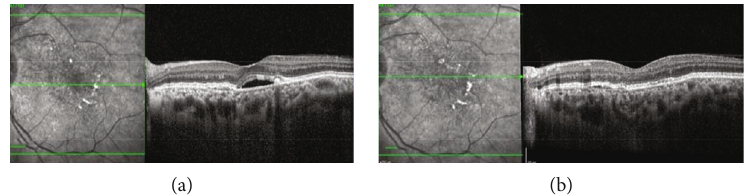
Figure 8: Pre- and posttreatment spectral-domain optical coherence tomography (SD-OCT) images ((a) and (b)) showing resolution of subretinal fl uid and persistent re fl ective deposits on infrared re fl ectance (IR)